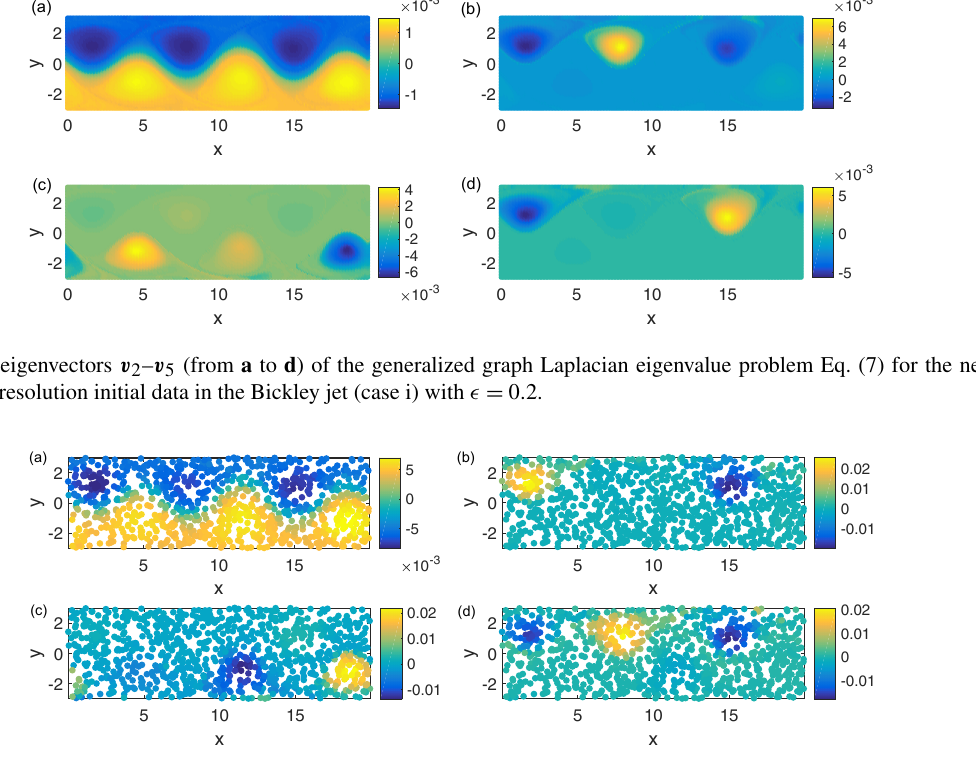
Figure 4. Leading eigenvectors v 2 – v 5 (from a to d ) of the generalized graph Laplacian eigenvalue problem Eq. (7) for the network con- structed from 1000 random initial conditions in the Bickley jet (case ii) and (cid:15) = 0 .